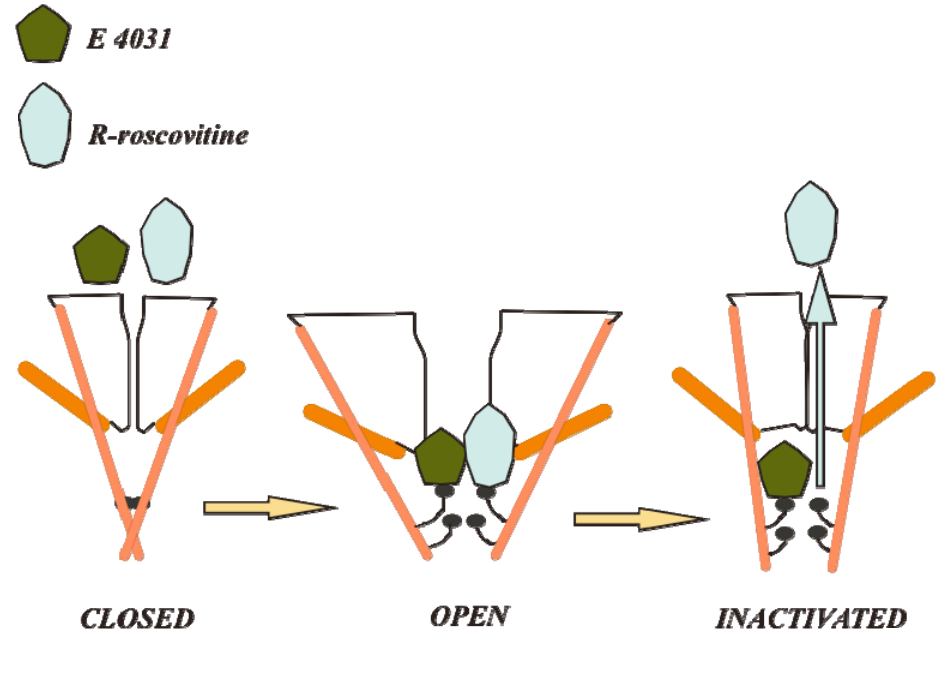
Figure 1 . Differences in the state-dependent block of hERG1 channels by R-roscovitine and class III anthyarrhythmic drugs (E